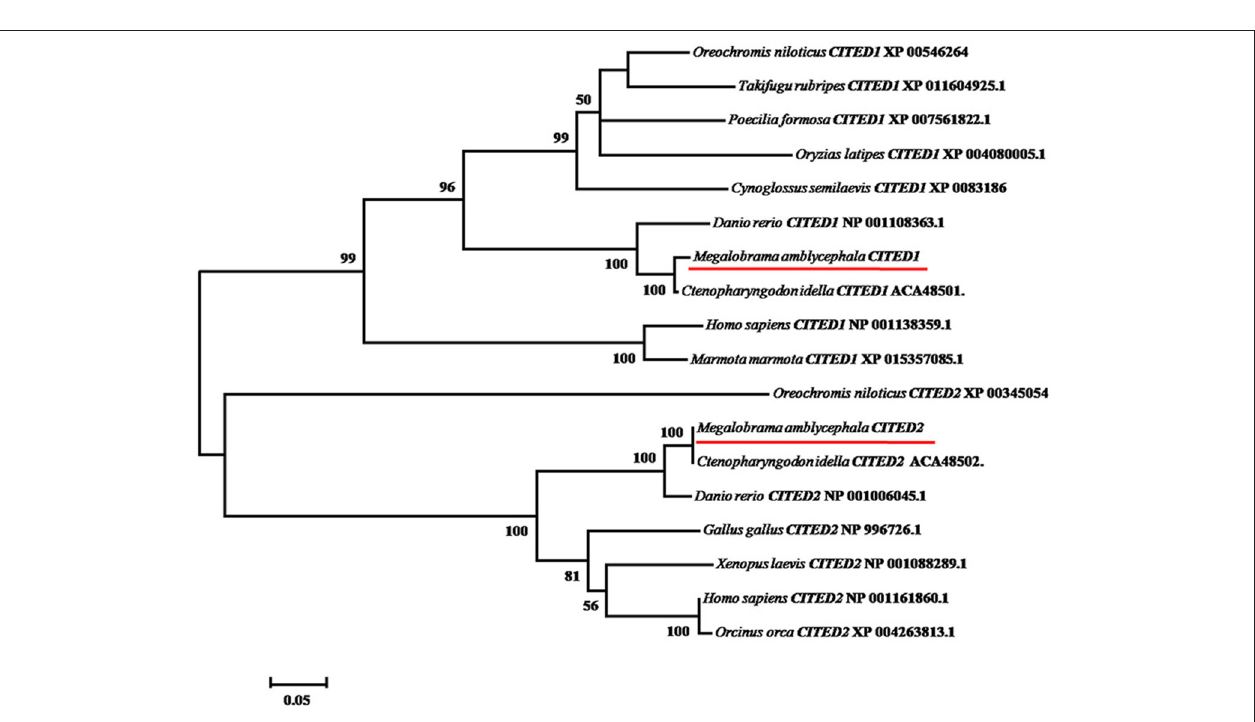
FIGURE 2 | Phylogenetic analysis of vertebrate CITED1 and − 2. Accession numbers of sequences retrieved from GenBank and European Molecular Biology Laboratory are shown. The tree was constructed by the neighbor-joining method using MEGA 6.06 software. The bootstrap values derived from 1,000 replications are shown. Objective gene has been highlighted in red